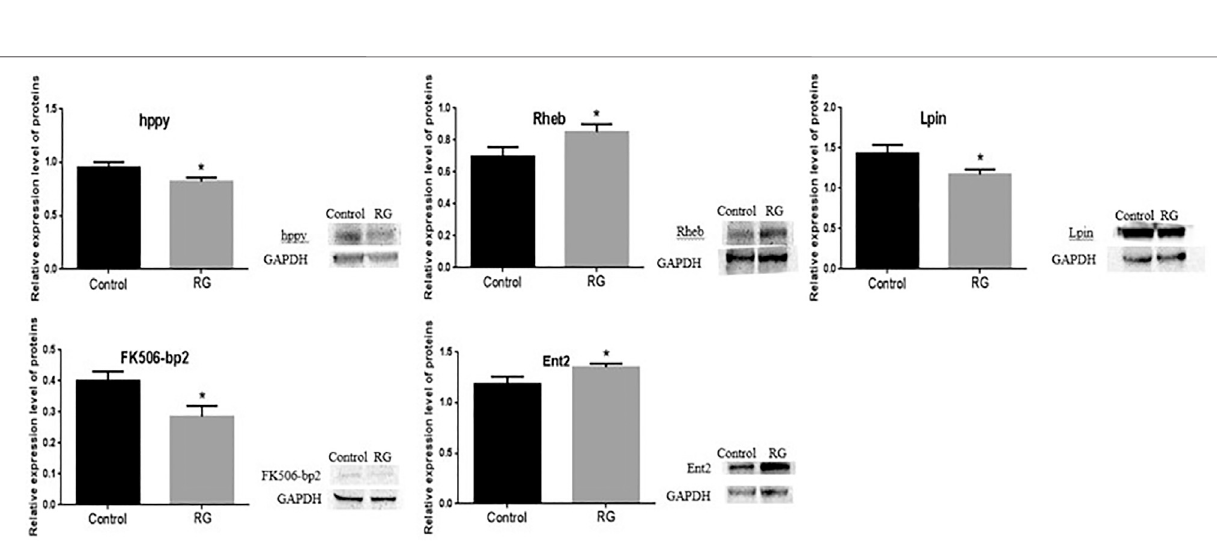
Frontiers in Pharmacology |